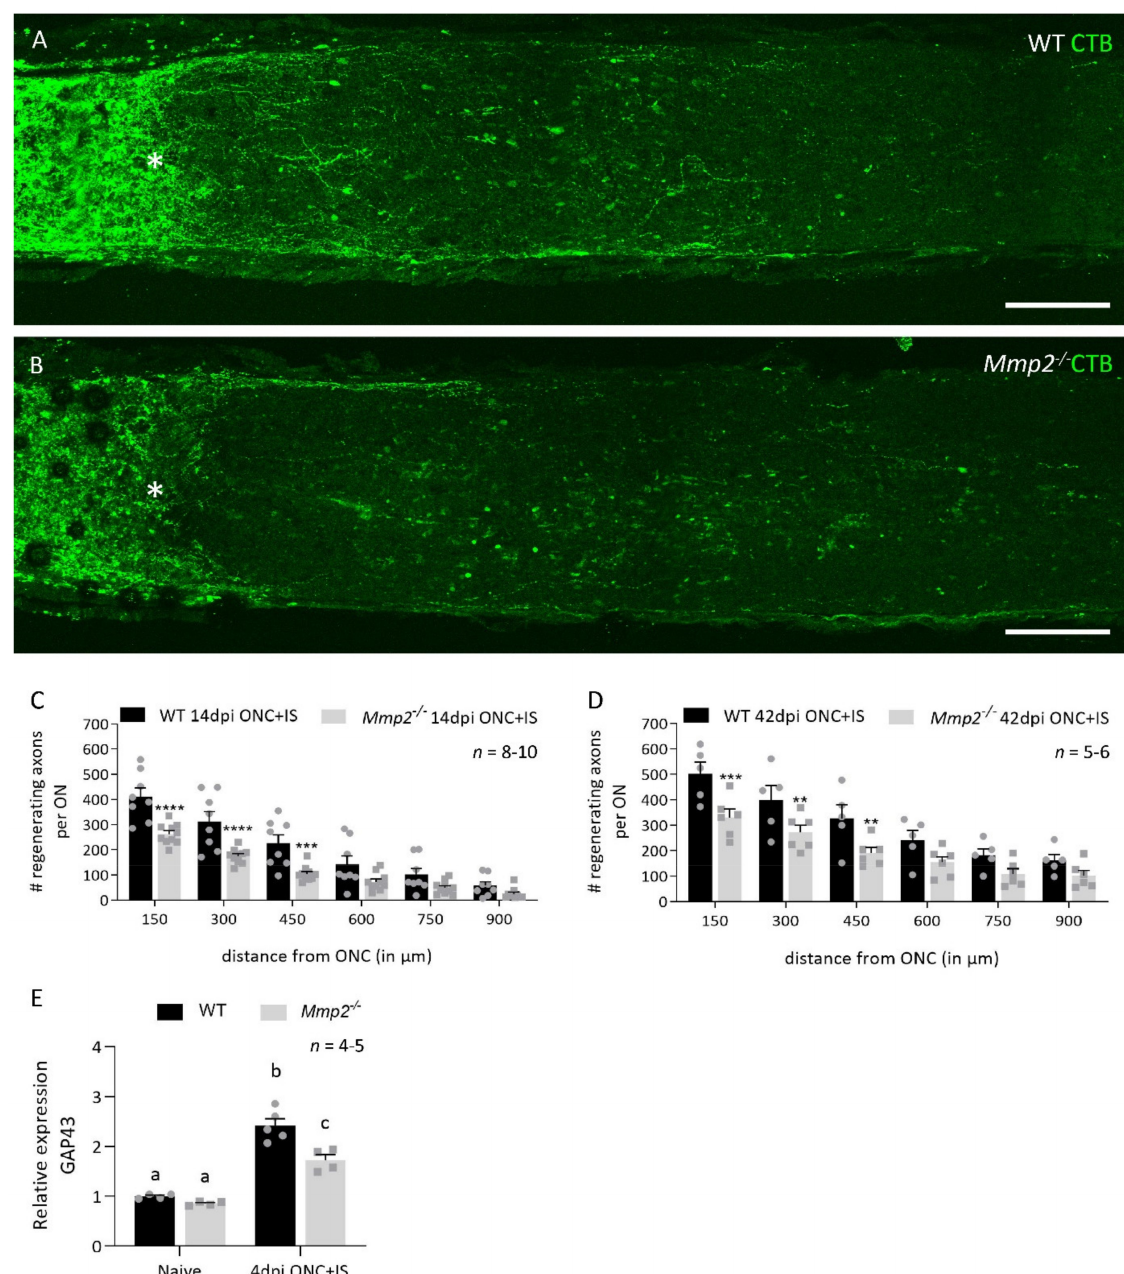
Figure 1. Mmp2 -/- mice have a reduced number of regenerating axons compared to WT mice. ( A , B ) The number of regenerating axons visualized using CTB tracing in WT ( A ) and Mmp2 -/- ( B ) mice at 14 dpi ONC+IS. The ONC site is indicated with an asterisk. Scale bar: 100 µ m. ( C ) Graphic of the number of CTB + axons per optic nerve in function of the distance from the ONC site comparing the number of CTB + axons in WT (black) and Mmp2 -/- (grey) mice at 14 dpi ONC+IS. The number of CTB + axons was counted every 150 µ m from the ONC site till 900 µ m. ( D ) Graphic of the number of CTB + axons per optic nerve in function of the distance from the ONC site comparing WT (black) and Mmp2 -/- (grey) mice at 42 dpi ONC+IS. ( E ) qRT-PCR data showed the expression of GAP43 at 4 dpi ONC+IS in WT and Mmp2 -/- mice. Data are relative expression values compared to the expression value in naive WT retinas (fold change). Data are shown as mean ± SEM. Repeated measures two-way ANOVA for axonal regeneration analysis followed by Sidak’s multiple comparisons test, * p < 0.05, ** p < 0.01, *** p < 0.001, **** p < 0.0001 for comparisons between genotypes. Repeated measures two-way ANOVA for qRT-PCR analysis followed by Tukey’s multiple comparisons test. Statistical significance between different time points is indicated using different